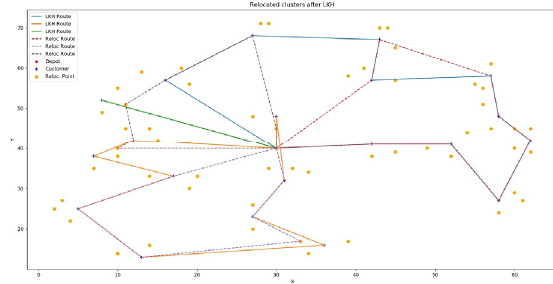
Fig. 7. Behavior of the objective function for the algorithm without packing considerations (Instance 4)